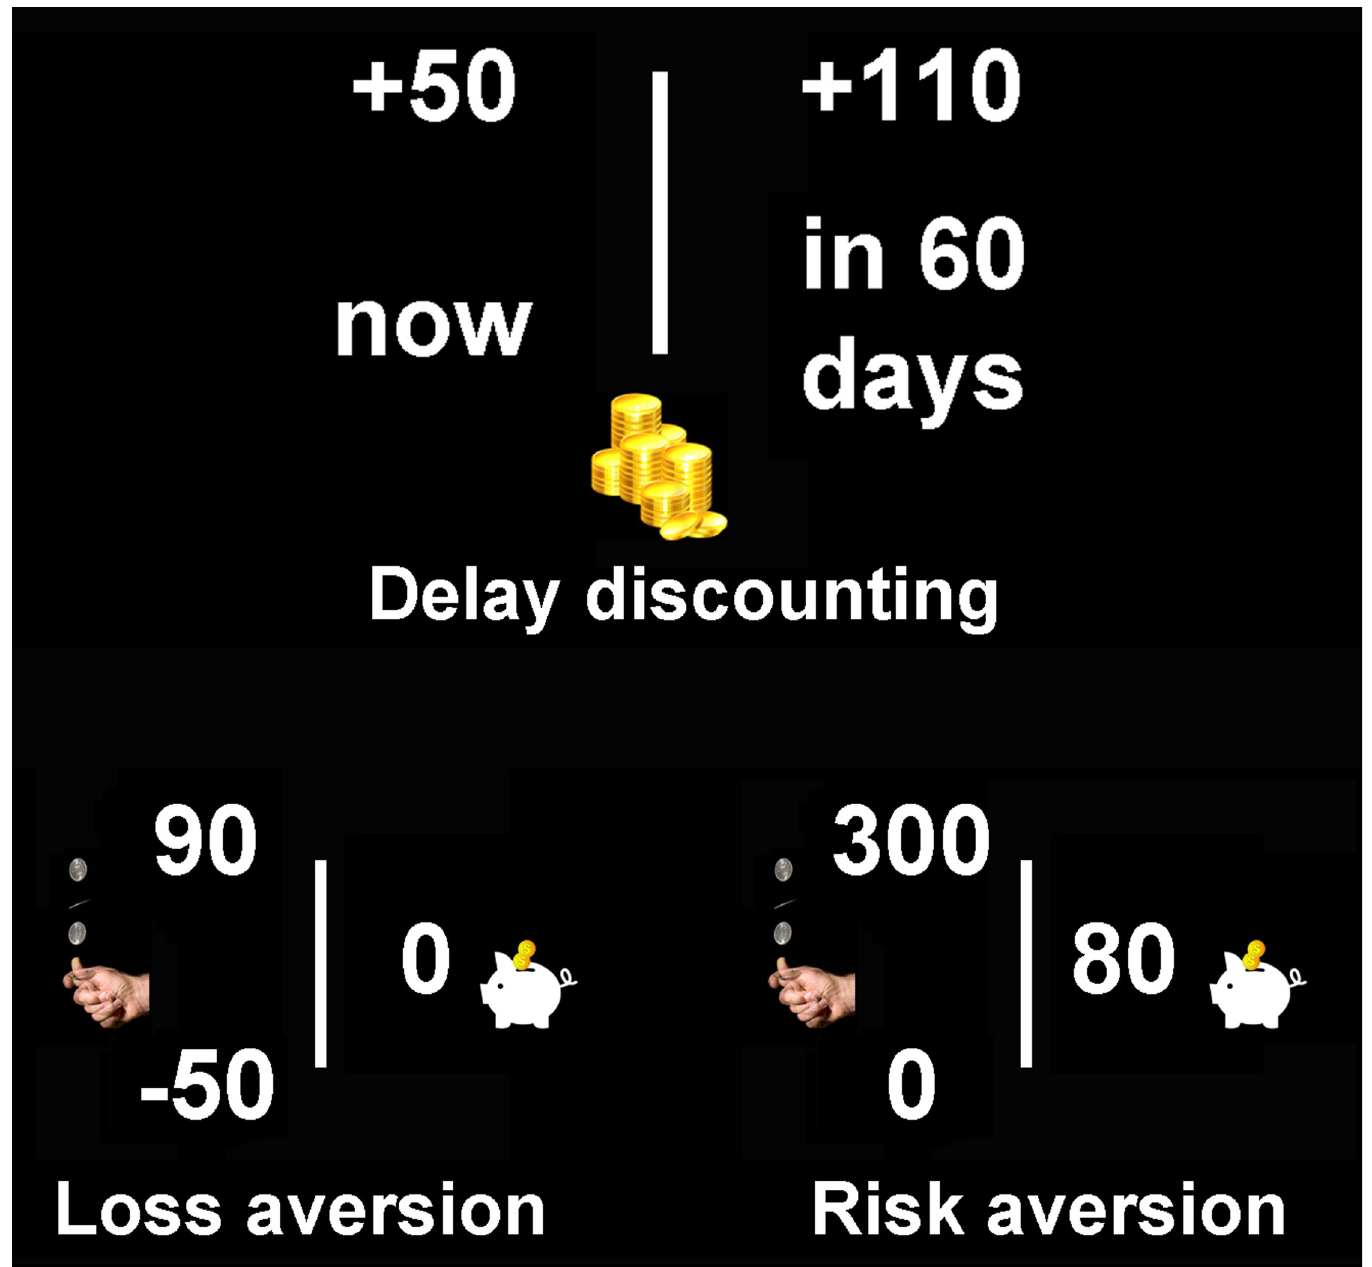
Fig 1. The figure shows example stimuli for the tasks assessing delay discounting (top), loss aversion (bottom-left) and risk aversion